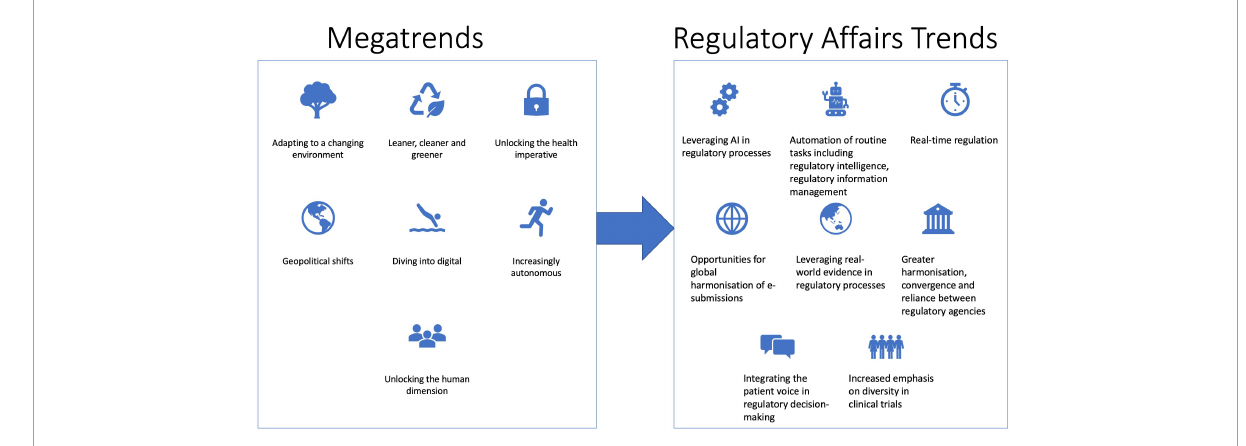
FIGURE1 Trends impacting the future of regulatory